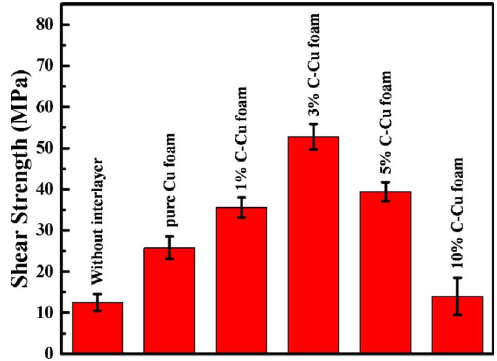
Figure 11: Effect of thickness of interlayer on shear strength at room temperature of the